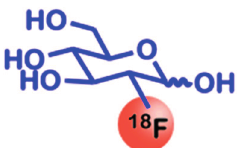
Figure 2. Chemical structure of 2-Deoxy-2-( 18 F)fluoro-glucose ([ 18 F]-FDG). [ 18 F]-FDG is taken up by the glucose transport system. As many cancer types show higher metabolic glucose turnover, [ 18 F]-FDG uptake is increased, leading to its accumulation in cancer tissue. Subsequently, imaging with positron emission tomography (PET) is possible due to the β + emitting radionuclide 18